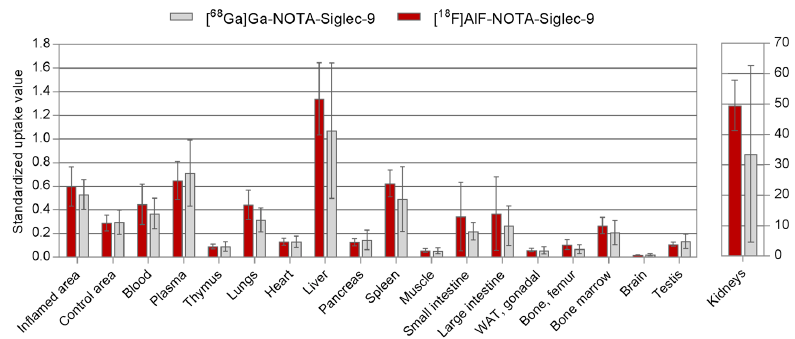
Figure 4. Standardized uptake values acquired 60 min post-injection by ex vivo γ -counting of excised tissues ( n = 7).